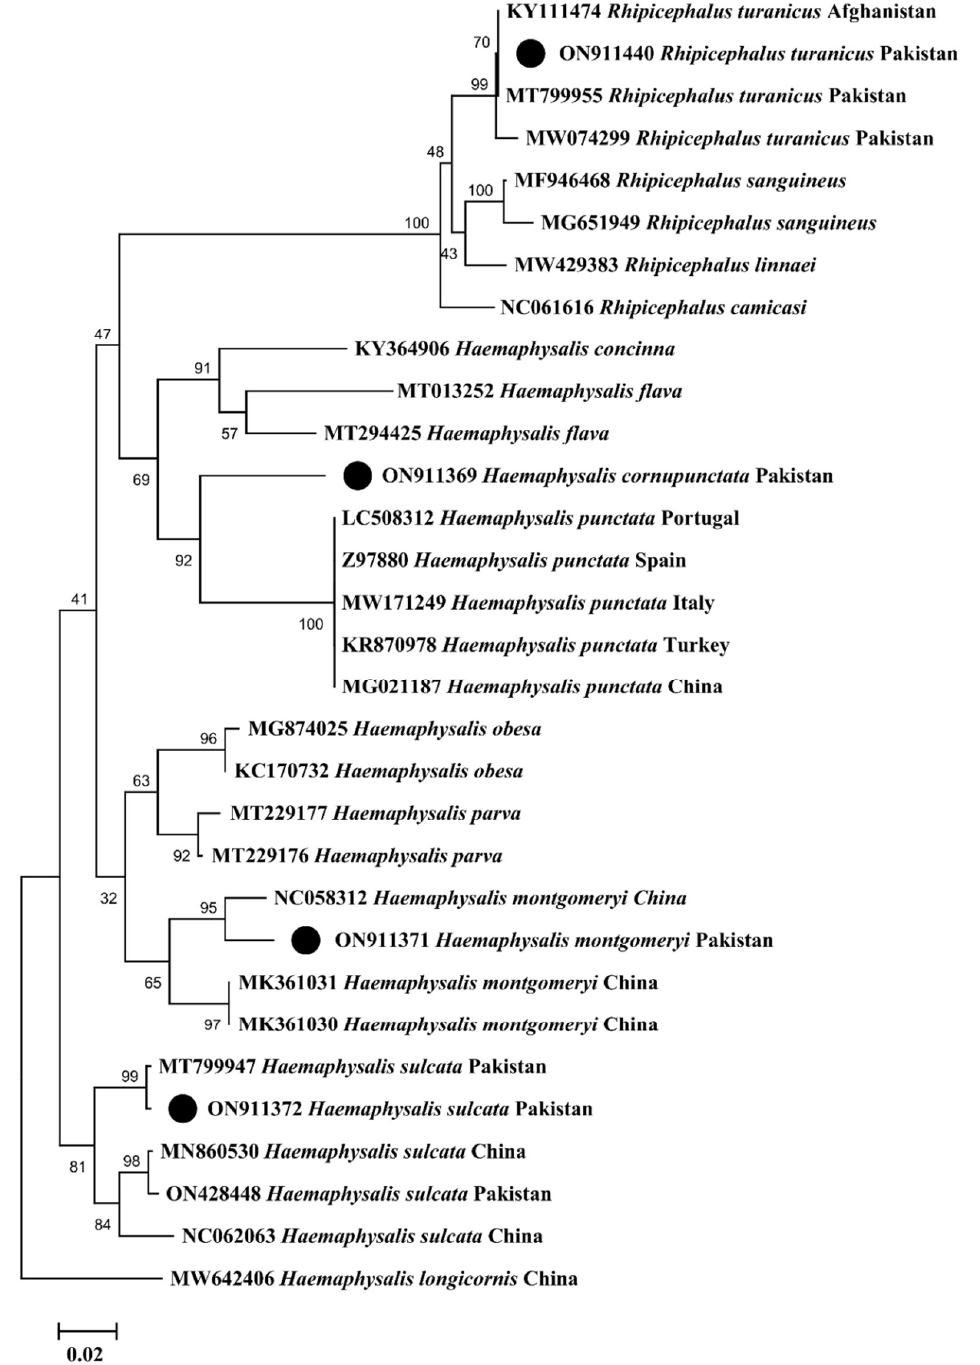
Figure 6. Maximum likelihood phylogenetic tree based on 16S rRNA sequences of R. turanicus , Ha. cornupunctata , Ha. montgomeryi and Ha. sulcata . Haemaphysalis longicornis was used as an outgroup, using supporting values (1000 replicons) at each node. The scale bar indicates the number of substitutions per site. The obtained sequences were represented with black circles.